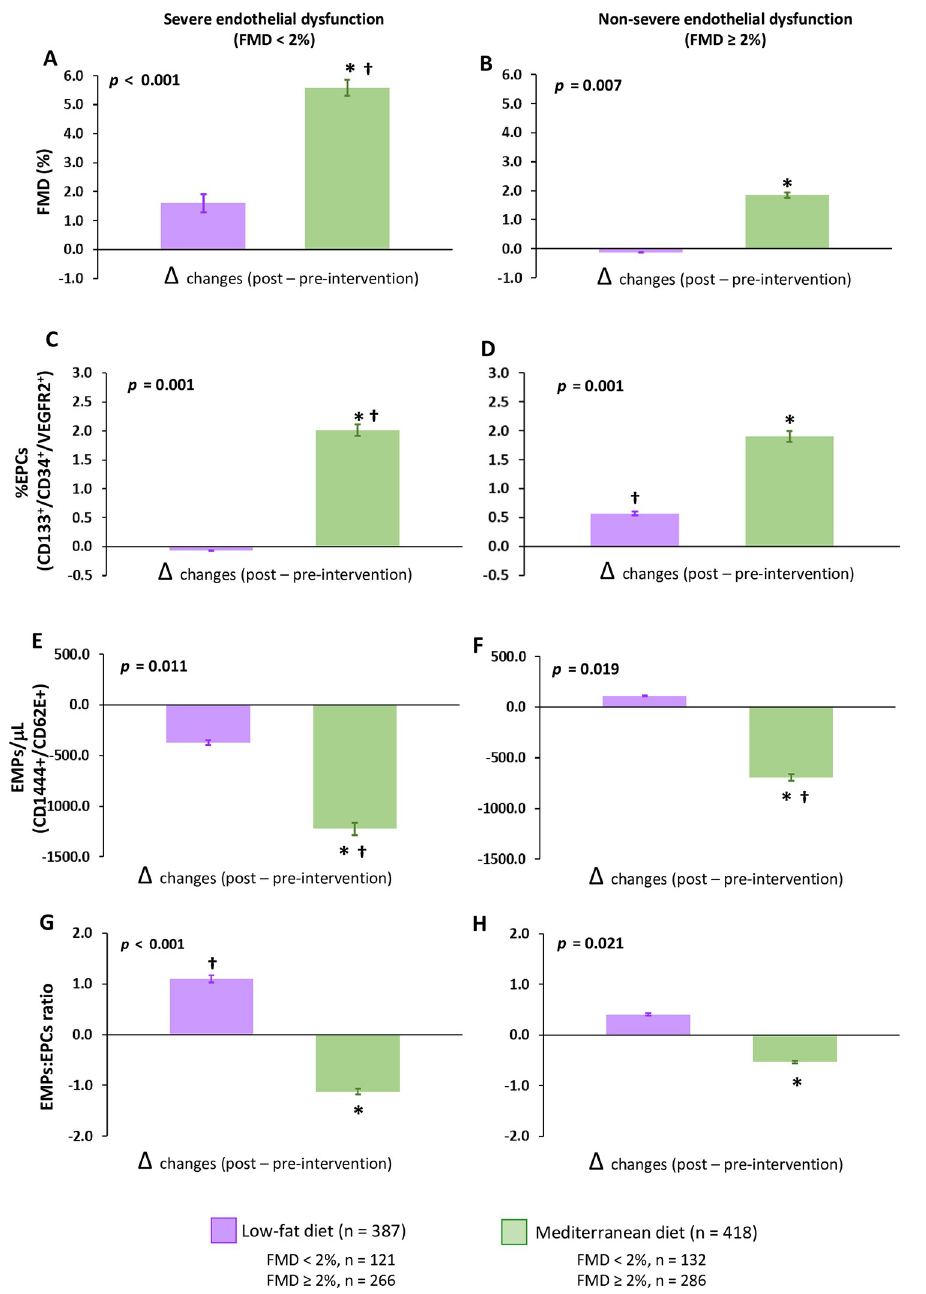
Fig 3. Effect of dietary intervention on endothelial function and other parameters related to endothelial functionality in patients classified according to the severity of endothelial dysfunction. (A and B) FMD, (C and D) circulating EPCs, (E and F) EMPs, and (G and H) EMP/EPC ratio. FMD < 2%, patients with severe endothelial dysfunction; FMD � 2%, patients with nonsevere endothelial dysfunction. Data are presented as Δ changes produced between post- and preintervention ± SE. Variables were compared using the analysis of variance (univariate ANOVA), adjusted by age, sex, and pharmacological treatment. � Significant changes between Mediterranean diet and low-fat diet ( p < 0.05). †Significant changes between post- and preintervention in each diet ( p < 0.05). CD, cluster of differentiation; EPC, endothelial progenitor cell; EMP, endothelial microparticle; FMD, flow-mediated dilation; VEGFR2, Vascular Endothelial Growth Factor Receptor 2.